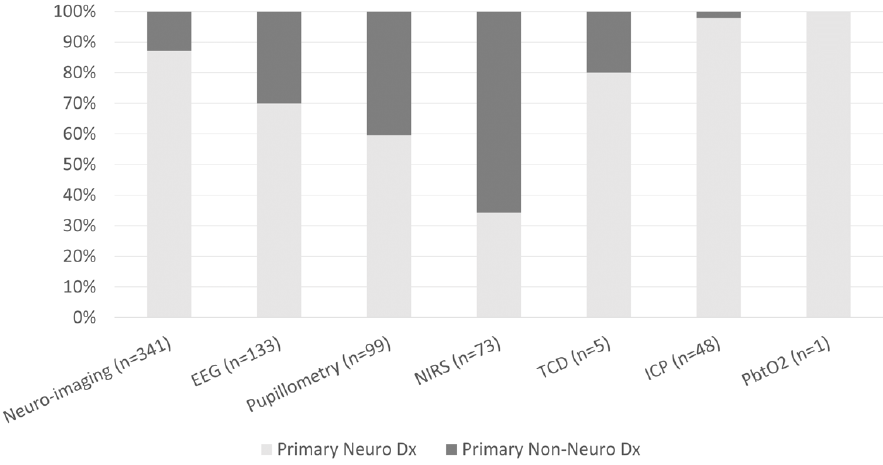
Figure 2. Percentage of patients who received neuro-imaging or neuromonitoring by primary neurological vs non-neurological diagnoses.